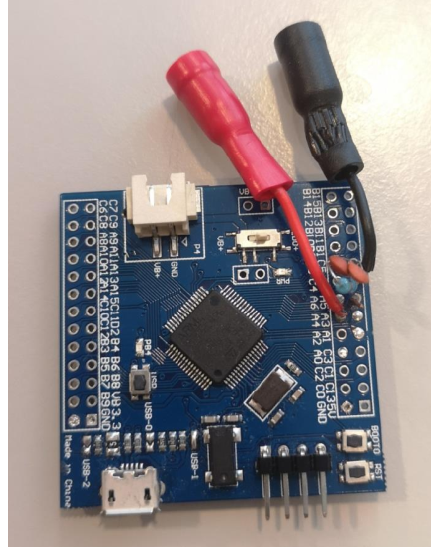
Figure 2: STM32L476 breakout board with feedback components and electrode connections